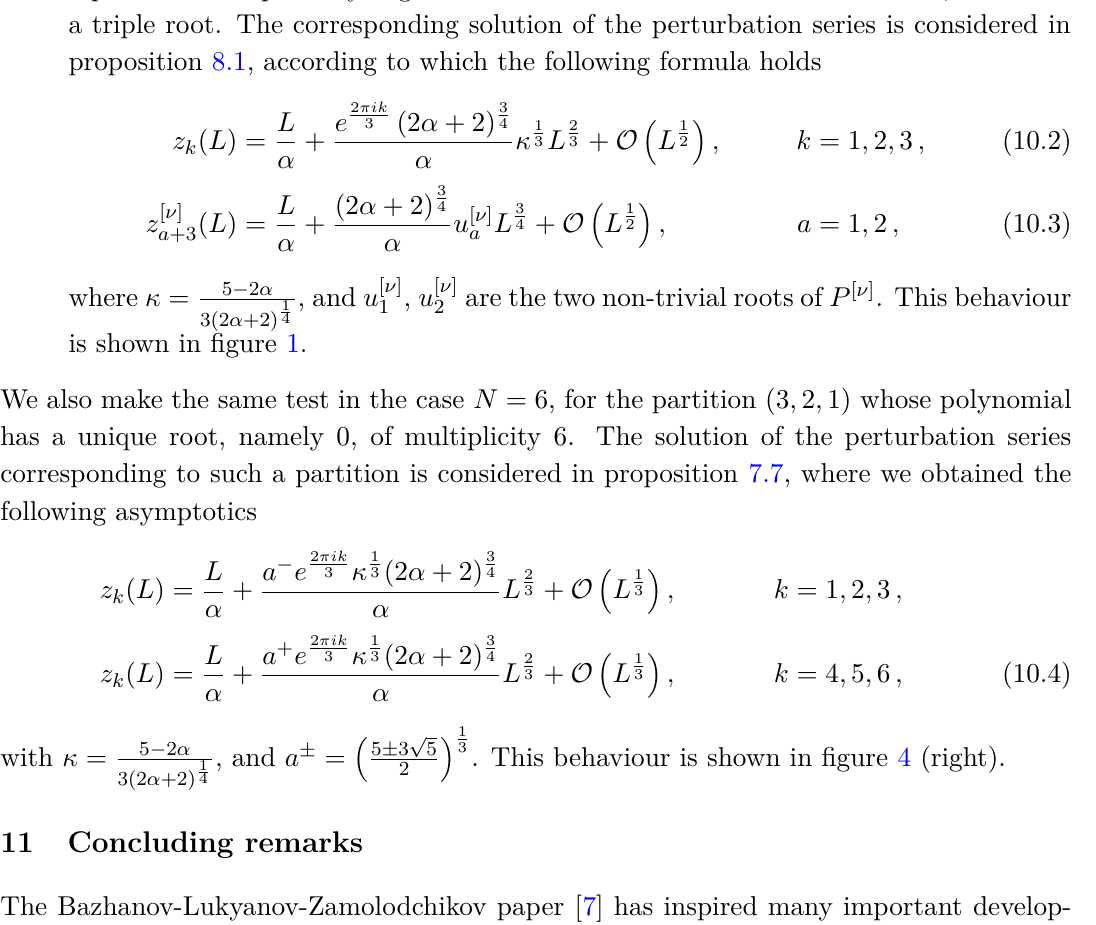
, in blue the perturbative 3 = 7 π 10 4 α 3